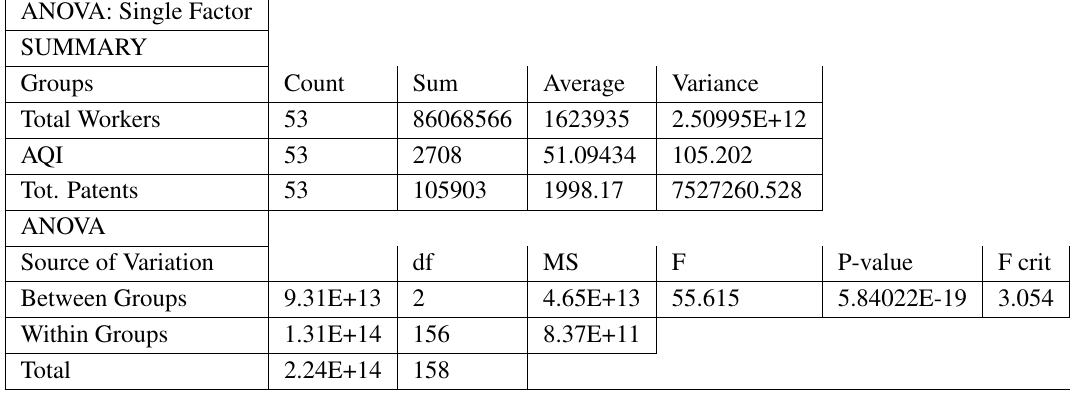
Table 4. ANOVA test with three variables for the year 2015